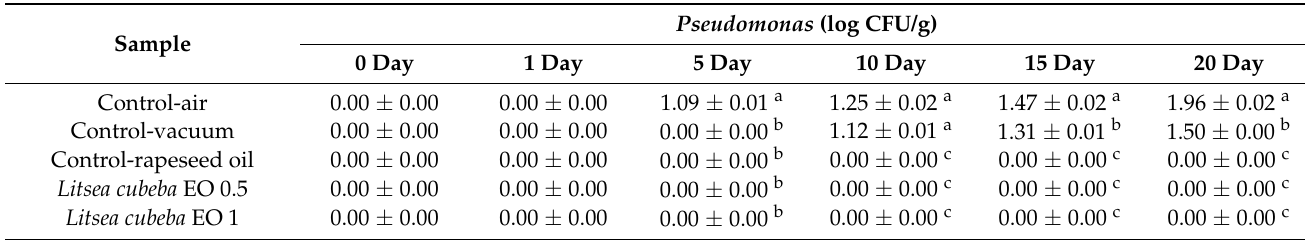
Table 3. Average numbers of Pseudomonas spp. log CFUg in samples of deer meat during 7 days of storage at 4 ◦ C.